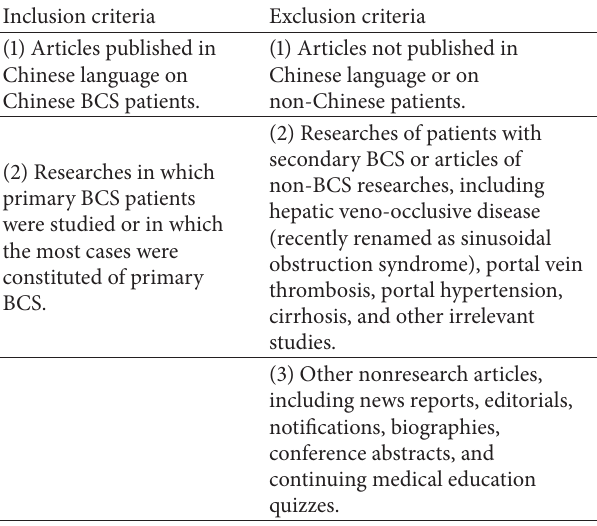
Table 1: Inclusion and exclusion criteria of the articles